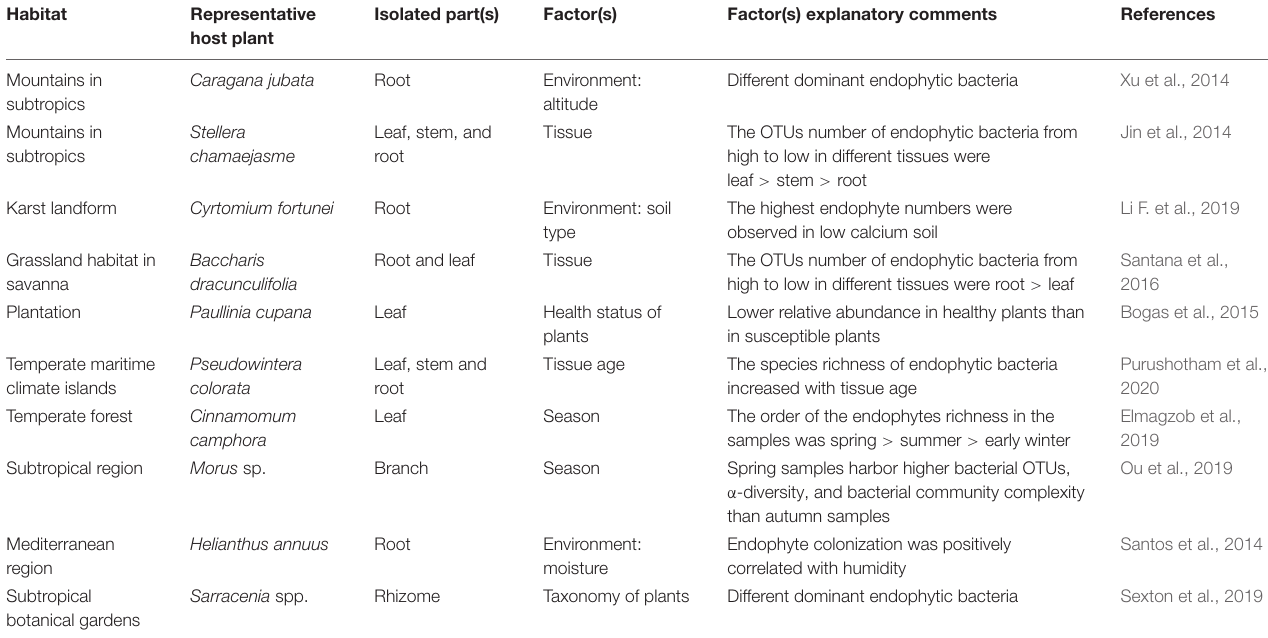
TABLE 1 | Factors affecting the community structure of endophytic bacteria in medicinal